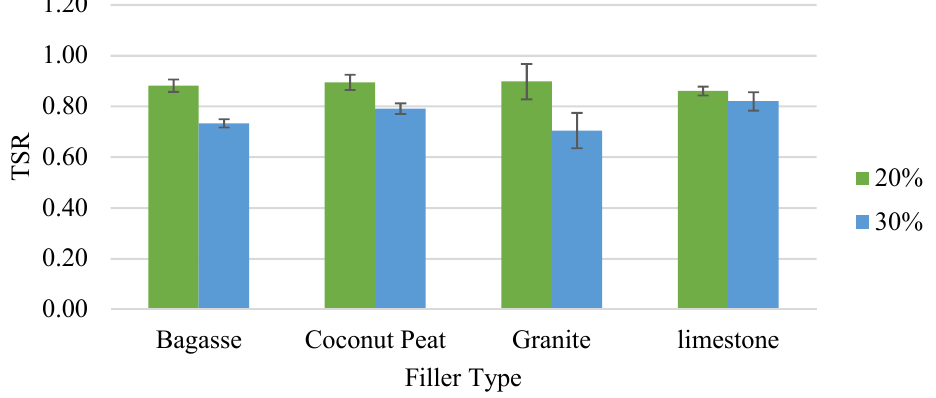
Figure 6. Tensile strength ratios (TSR) of ITS test after moisture of asphalt mixtures with limestone aggregate for all filler types.